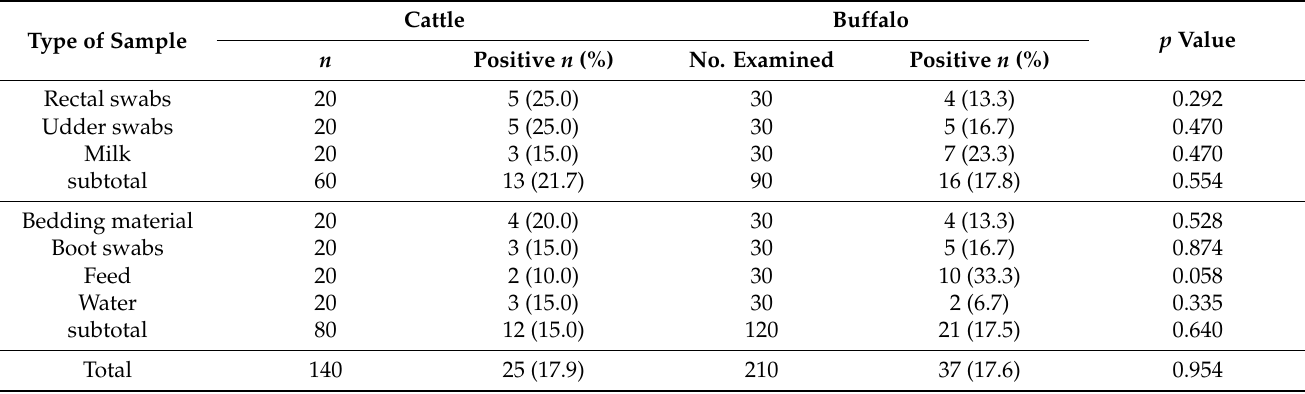
Table 1. Occurrence of S. aureus in samples collected from cattle, buffalo, milk and their environments.